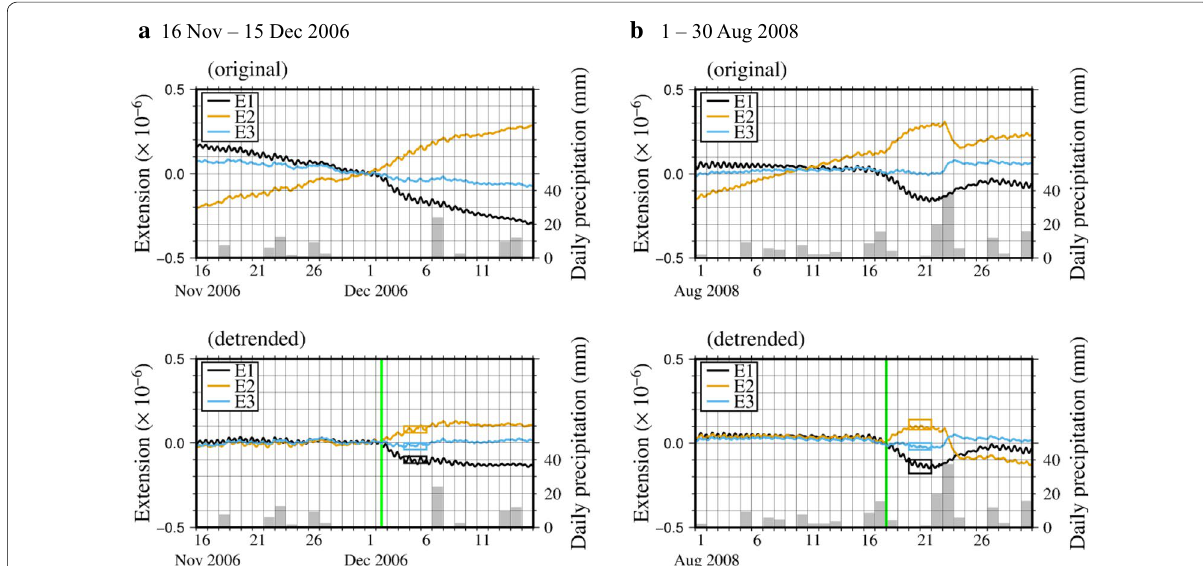
Fig. 7 Strain changes in the directions of components E1–E3 at station ISA during the two periods. a 16 November–15 December 2006 and b 1–31 August 2008. In each set of subpanels, the top plot shows the original time series, and the bottom shows the time series with the linear trend (estimated before the event of interest) removed from all data. Vertical green lines indicate the onset of rapid inflation that we use to estimate the strain offset. The variations within the colored boxes in the detrended graphs were used to estimate the magnitude and uncertainty of the strain offset. Note that the error ranges for E1 and E2 in b are slightly shifted to include the effect of the preceding rainfall. Daily precipitation at EBN is also shown (bar graphs)